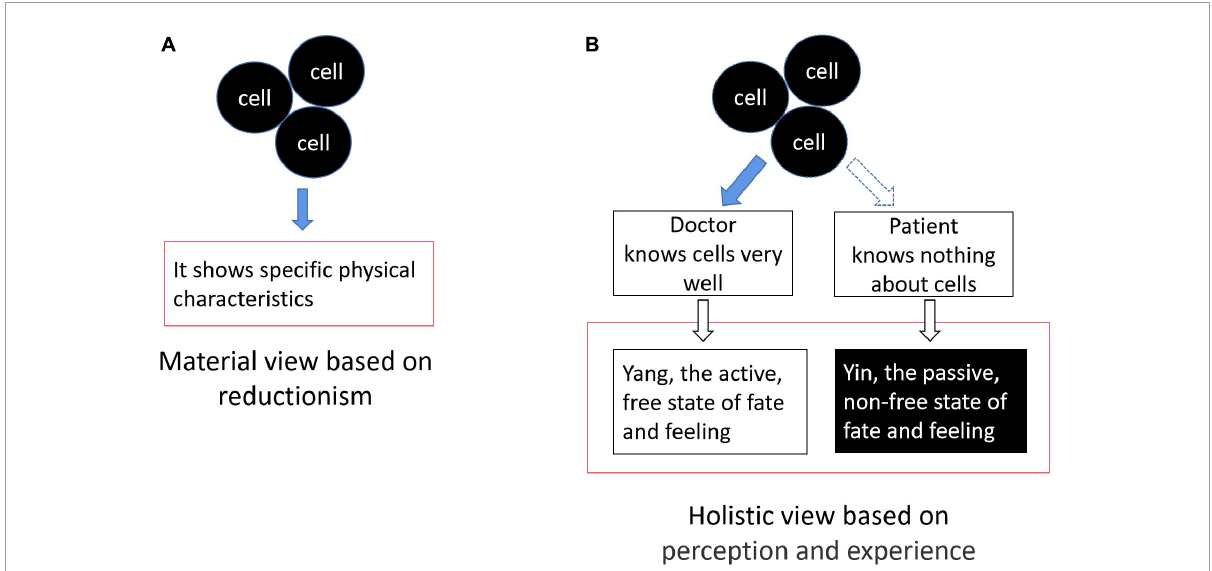
FIGURE1 The material view and the holistic view put different emphasis on objectivity. (A) Cells are considered objective material entities that are the same for everyone whether you know/observe it or not. This paradigm focuses on external objectivity based on observation. (B) Understanding the rules of the cell can cure disease, although this effect is universally applicable, however, the different experience on the “same and objective” cells results in different fates. Different “fates” are also another aspect of objectivity. This paradigm emphasizes the objectivity of feelings and experiences rather than external physical